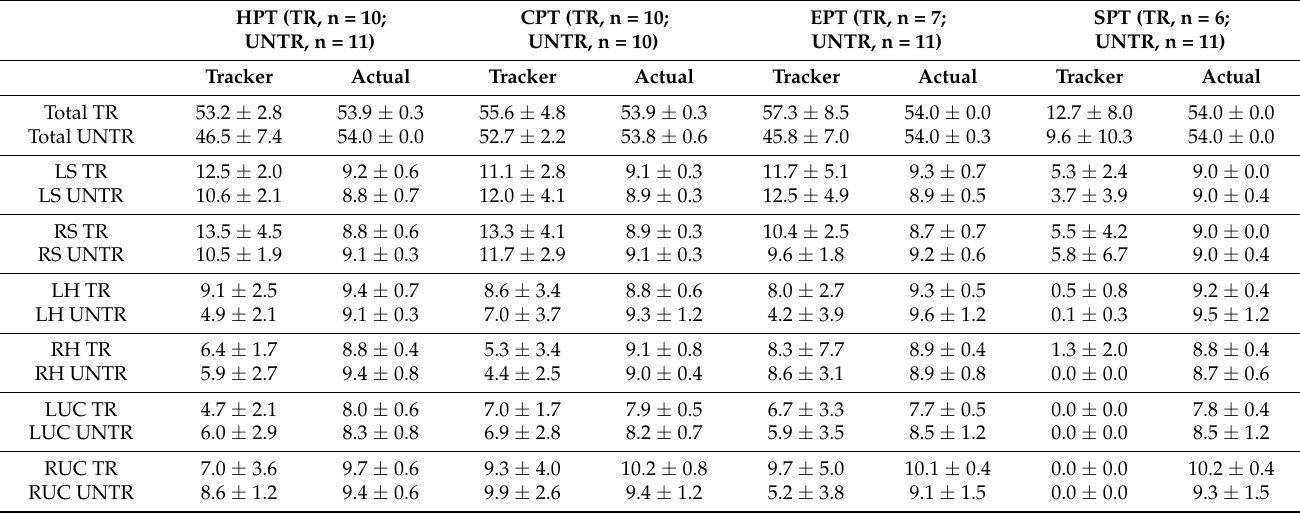
Table 3. Mean and standard deviation of shadow boxing punches that were recorded by each punch tracker and the actual punches that were thrown.